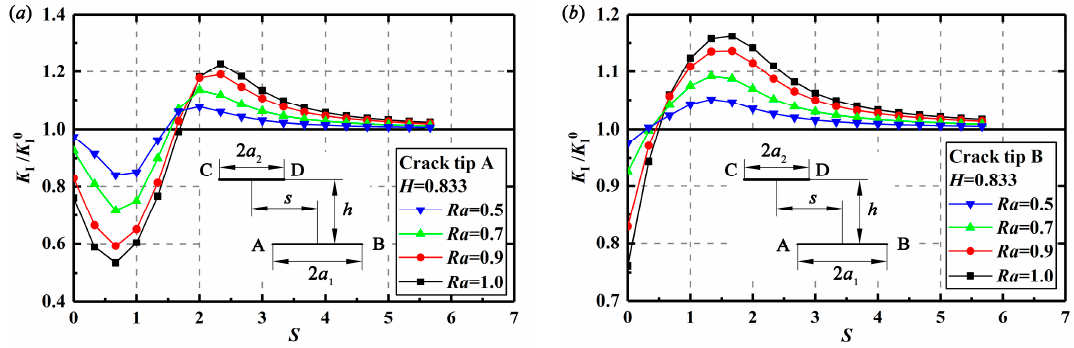
Figure 8. Relationship between K I / K I0 and S with different Ra at H = 0.833: ( a ) K I / K I0 at crack tip A and ( b ) K I / K I0 at crack tip B.